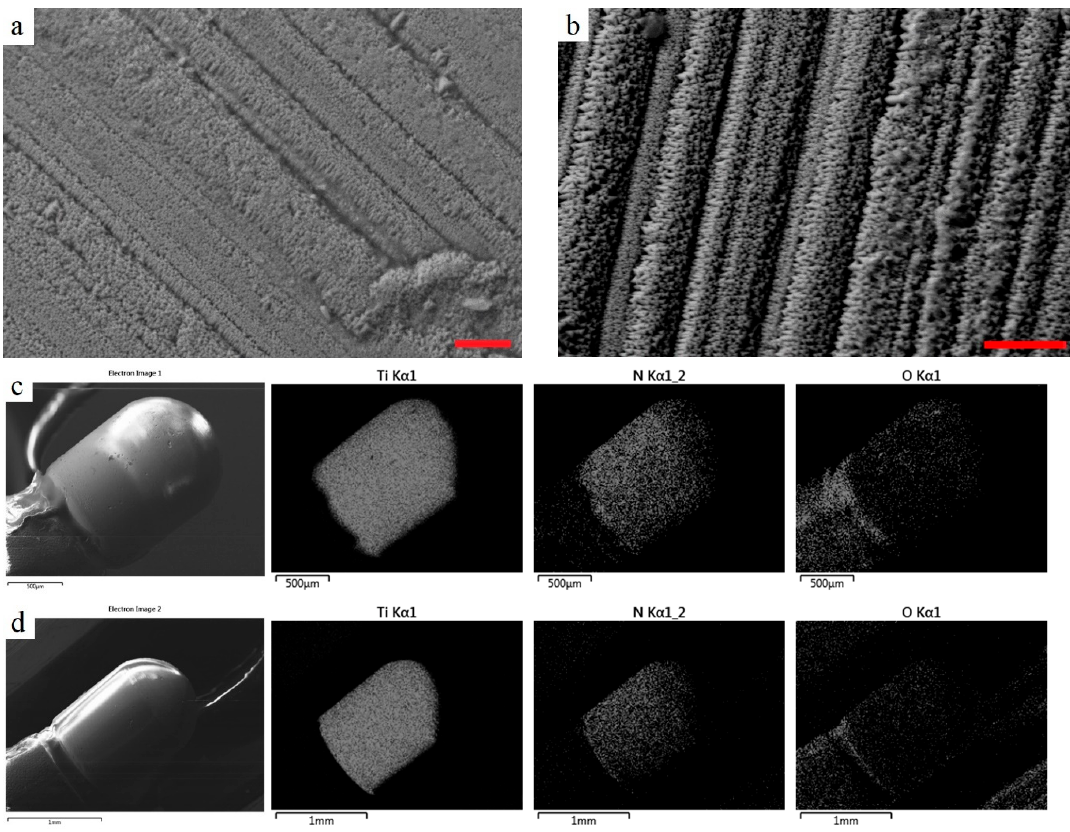
Figure 7. ( a ) Close-up SEM image (magnification: 10,000 × ) of an electrode in group 1 (20 mA—200 Hz), showing that the surface structure is still intact (scale bar: 10 µ m). The same is true for ( b ), showing the detailed structure of an electrode in group 4 (50 mA—400 Hz, scale bar: 10 µ m, magnification: 15,000 × ). ( c ) Overview SEM (magnification 450 × ) and corresponding EDX images of an electrode in group 1 show that the chemical composition of the electrode surface after pulsing was very similar to ( d ) the chemical composition of the electrode surface of an electrode in group 4. Also visualized by an overview SEM (magnification 450 × ) and corresponding EDX images of an electrode in group 4.